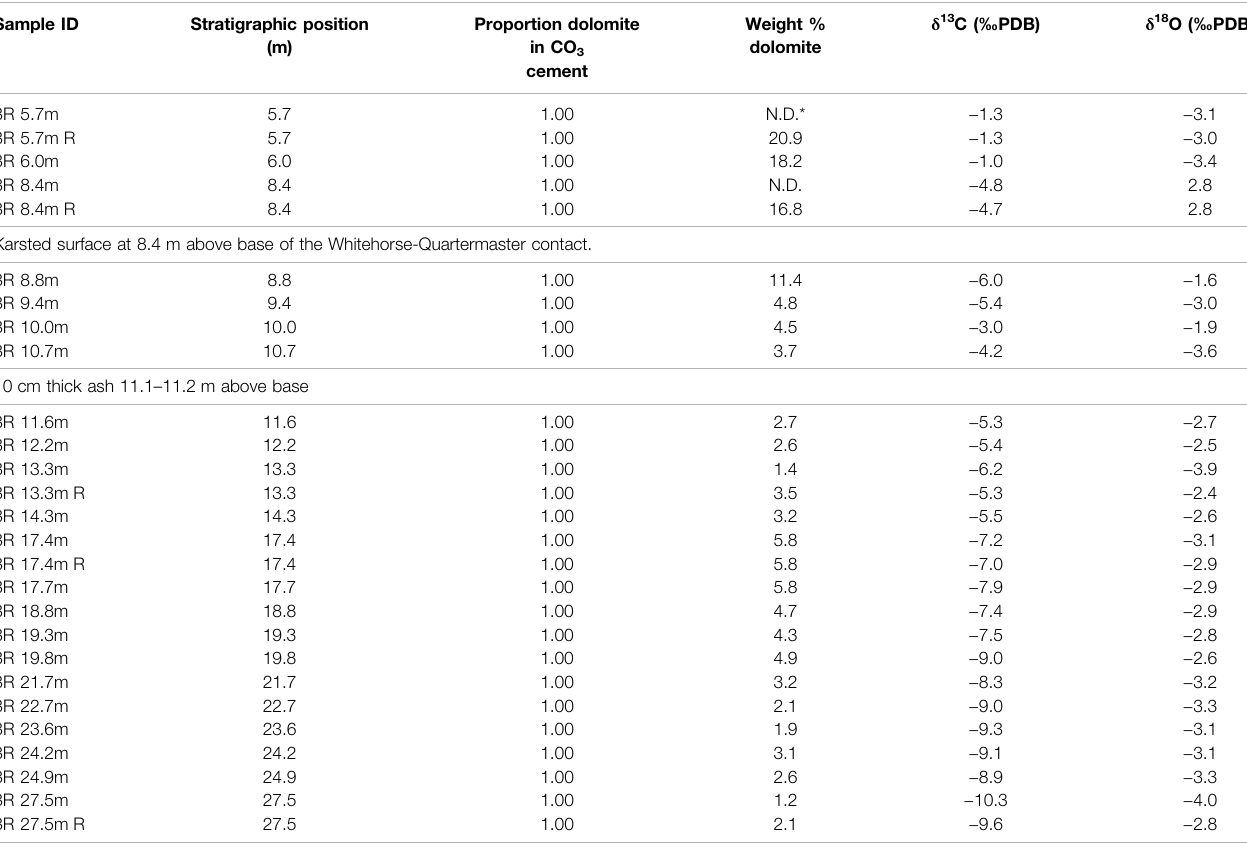
TABLE 8 | Results of analysis of dolomite cements from Highway 207. Sample